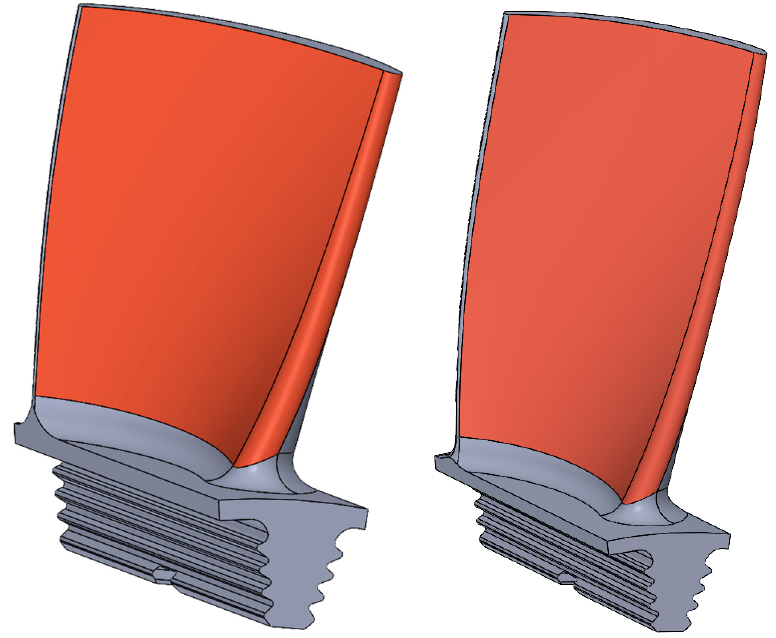
Figure 19. Upper and lower surface positions.